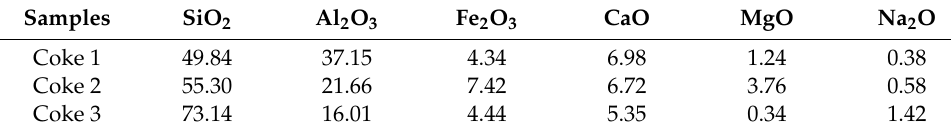
Table 4. The chemical composition of the ash in coke samples (wt%).